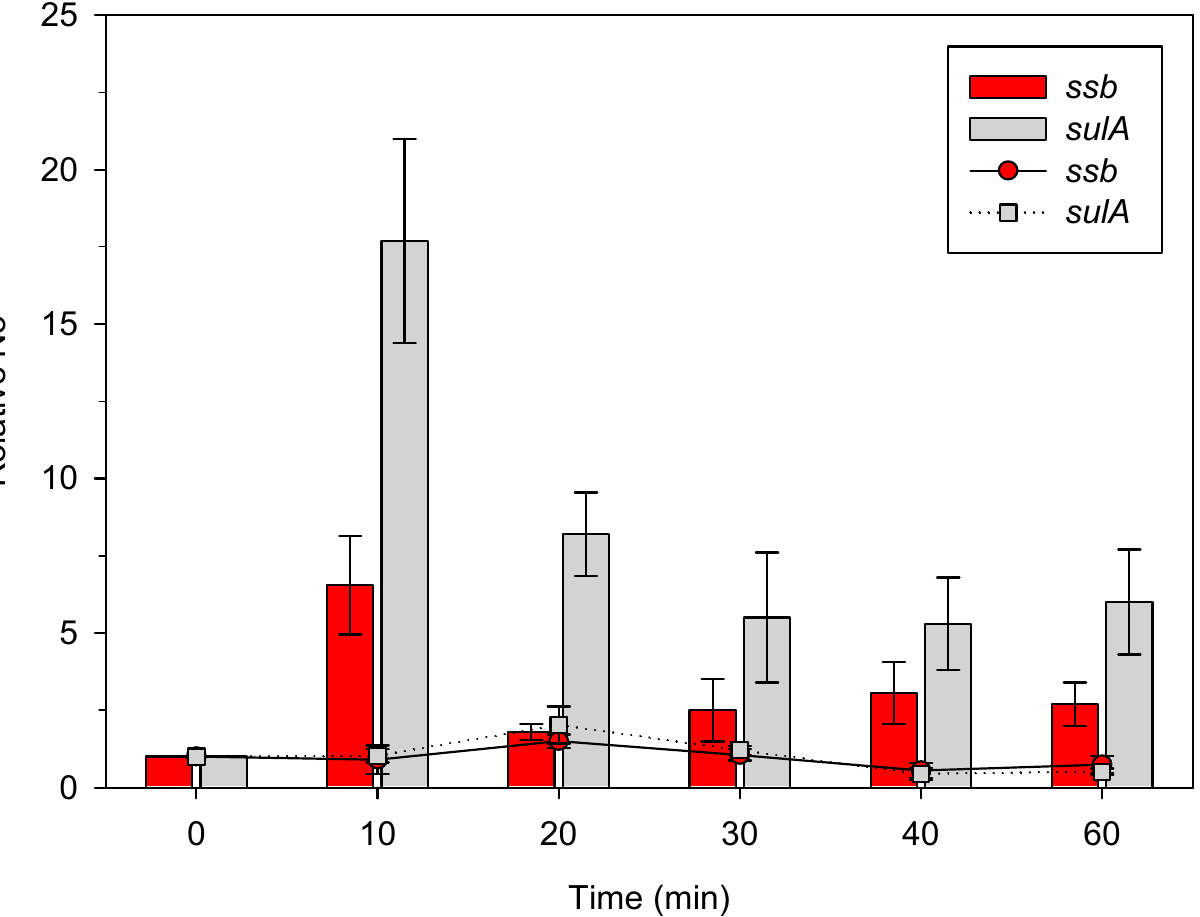
Figure 2. Expression of the ssb and the sulA gene in wild-type E. coli γ -irradiated with 400 Gy and incubated at 37 °C. Bacteria were irradiated when their exponential growth in LB medium reached OD 600 ∼ 0.4. Bars represent expression in irradiated bacteria (except at time 0), and dots and lines in unirradiated bacteria. No represents normalized average No value for the two genes. Each value is a mean of the three independent qRT-PCR experiments, with error bars representing standard deviation.